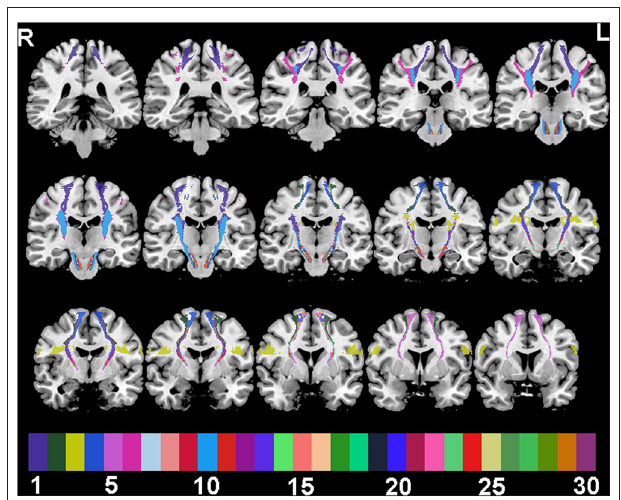
FIGURE 1 | SMATT tracts in a random colour-scale superimposed on 15 grayscale coronal T1-weighted anatomical slices. Colour indices are: 1 M1;